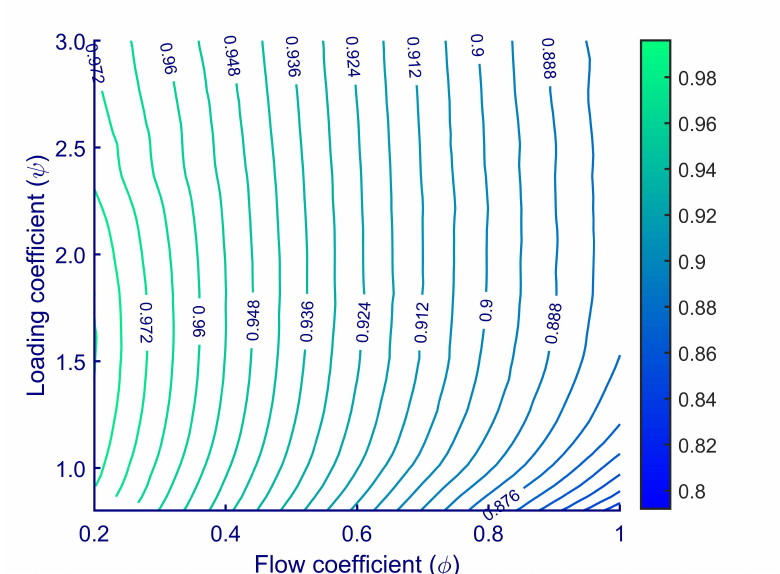
Figure 4. Contour plot for normalised sCO 2 turbine efficiency at Λ = 0.5 and 150